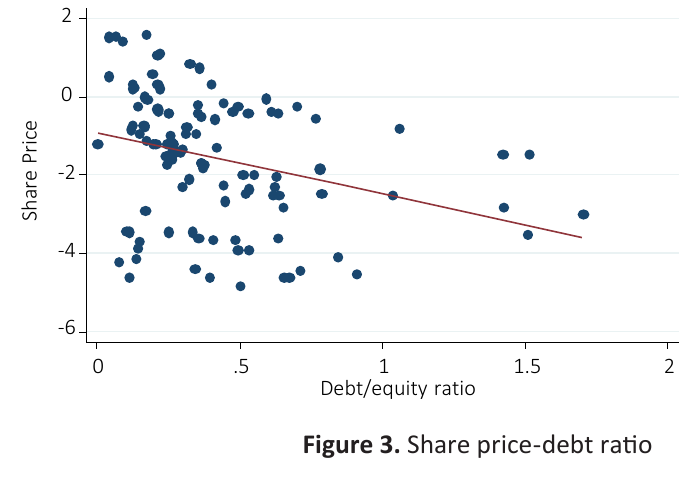
Figure 3. Share price-debt